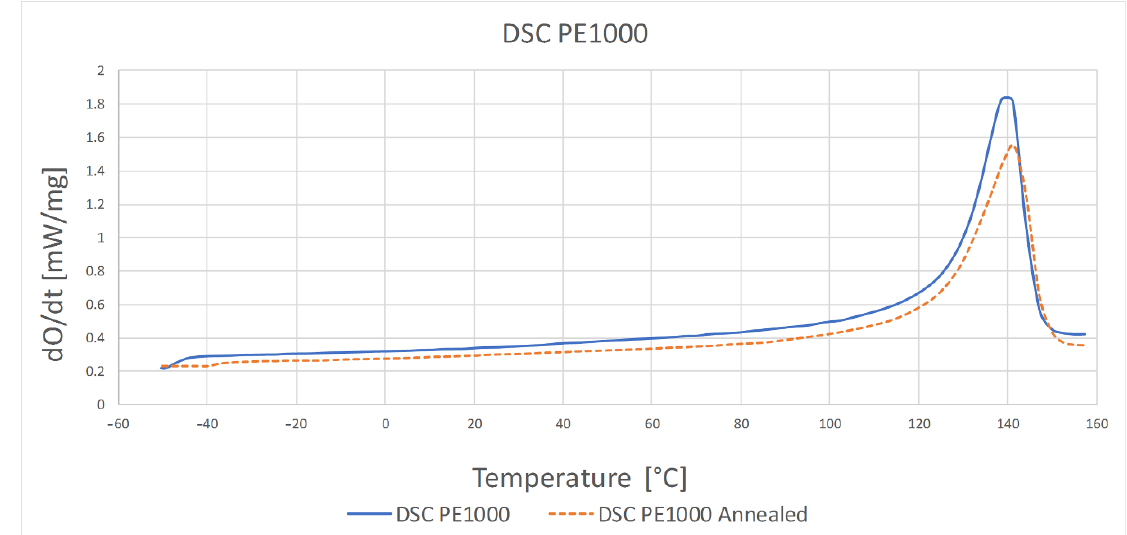
Figure 5. DSC thermogram for PVDA Tecaflon before and after heat treatment.